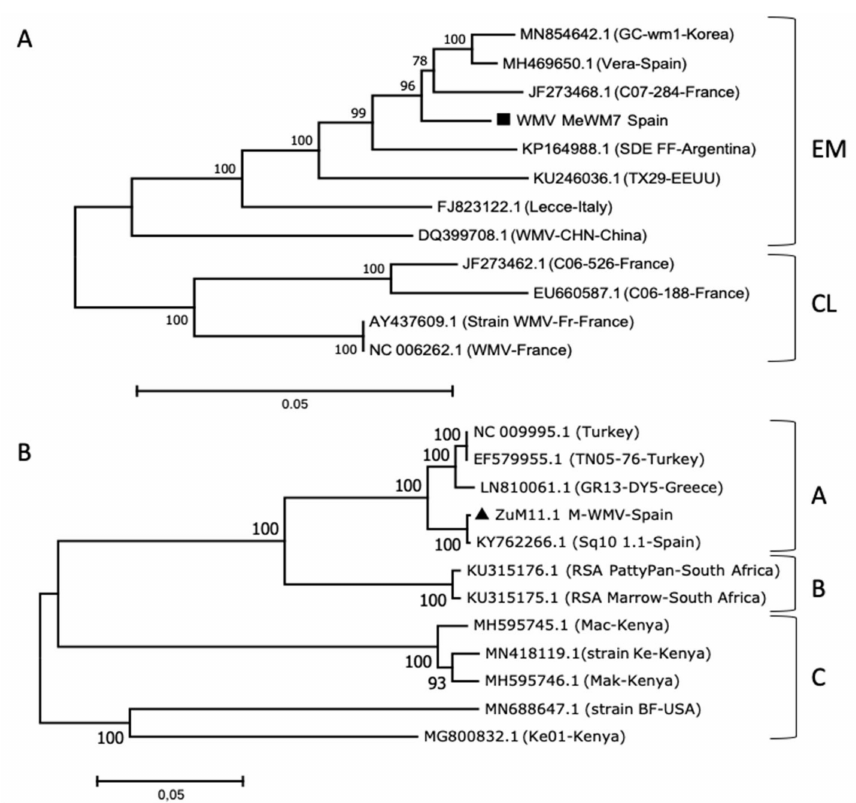
Figure 2. Phylogenetic relationships between complete genome sequences of the ( A ) WMV isolate MeWM7, and ( B ) MWMV isolate ZuM10, including complete sequences of another 11 full-length viral isolates available in the NCBI/GenBank database. The evolutionary history was inferred by using the maximum likelihood method, and the evolutionary distances were computed using the maximum composite likelihood method with 1000 bootstrap replications, using the General Time Reversible model. The Minimum Evolution tree was searched using the close-neighbor-interchange algorithm at a search level of 1. The genetic distances are presented as the lengths of the branches, and only branches with bootstrap values >70% are shown. Different clusters are indicated at the right for each corresponding